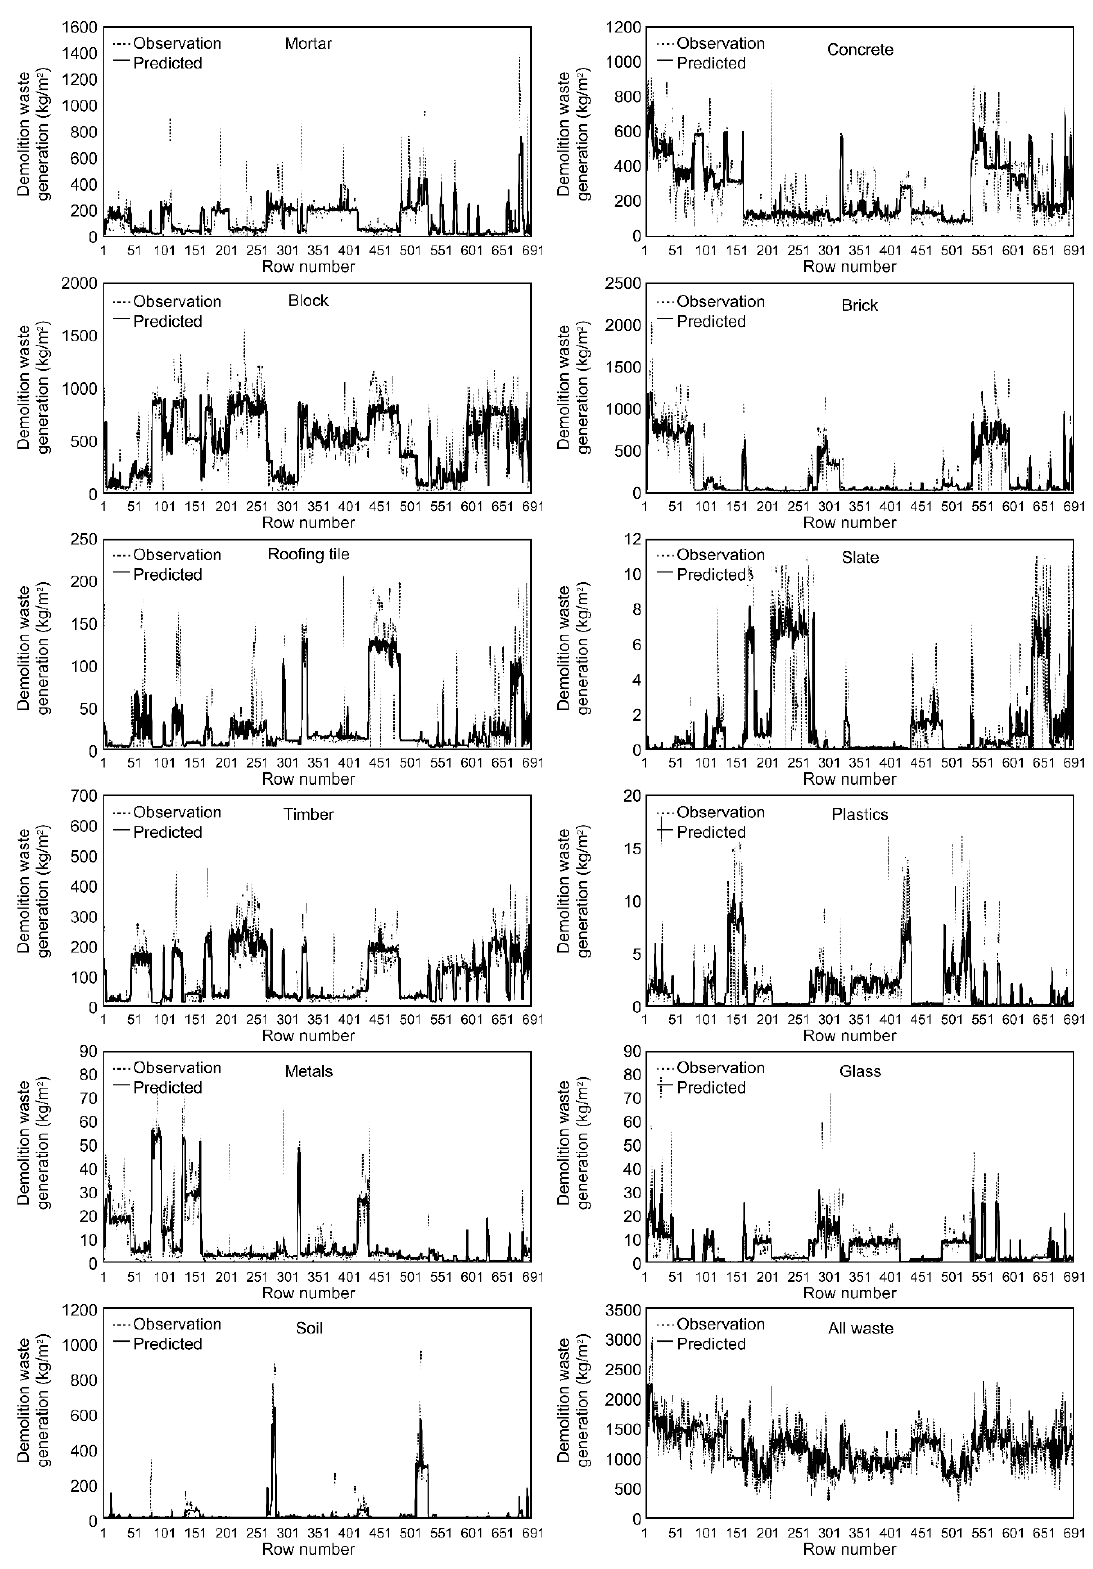
Figure 5. Modeling results for each demolition waste type produced by RF.